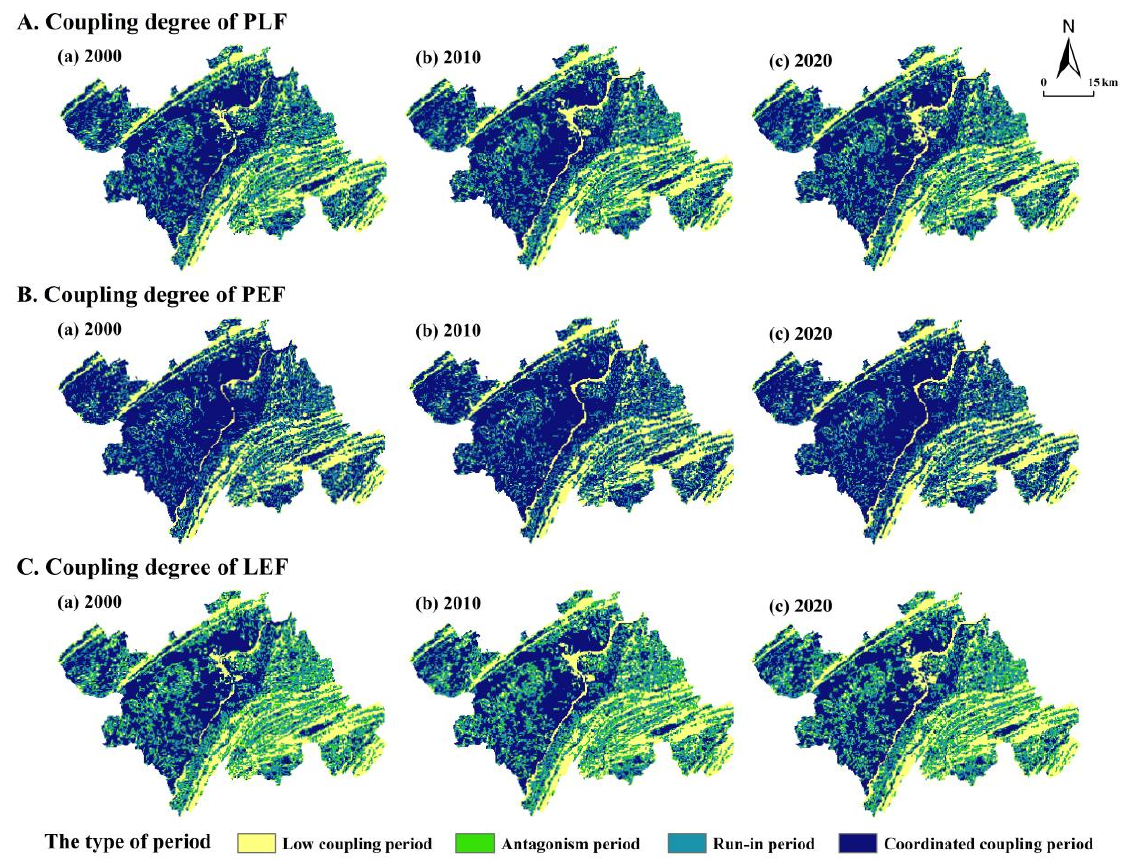
Figure 5. Coupling degree of PLF ( A ), PEF ( B ), and LEF ( C ).